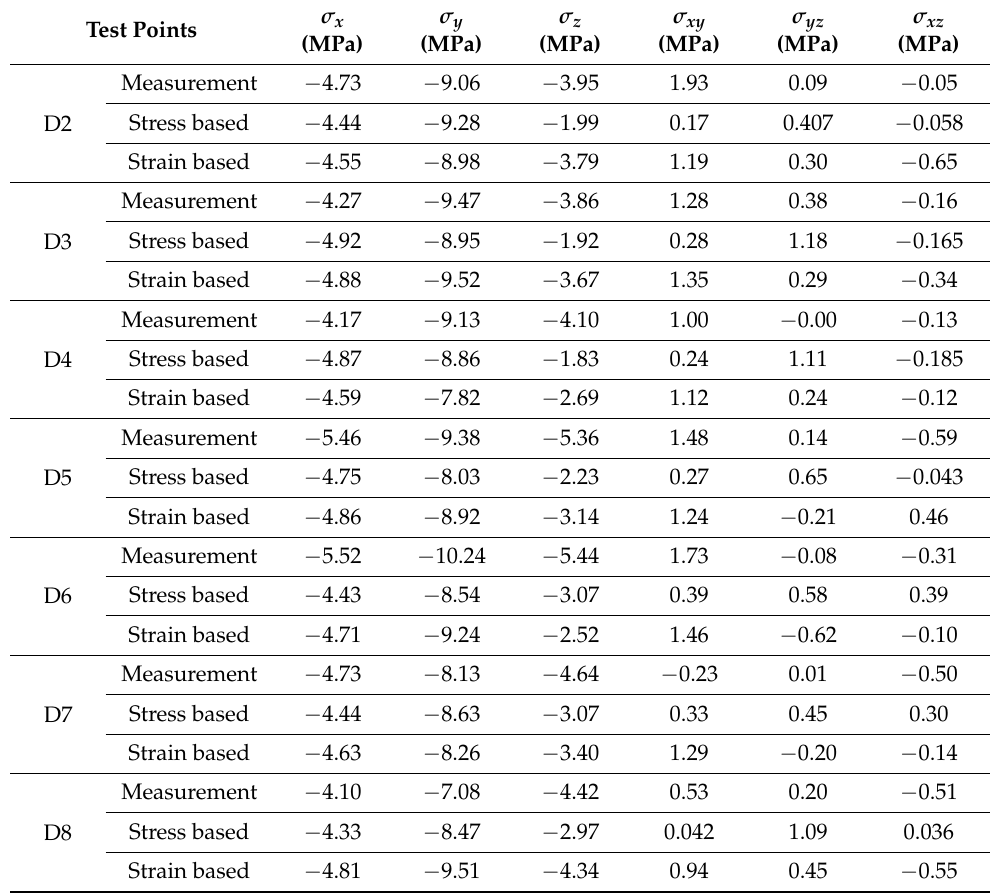
Table 2. Contrast data of stress component under calculating coordinate